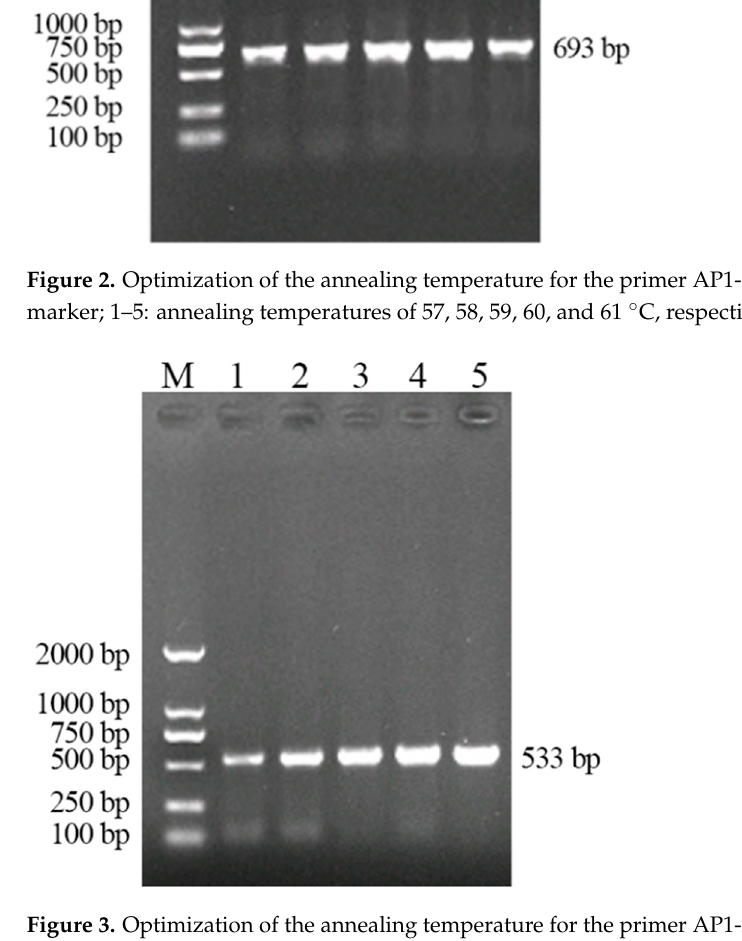
Figure 3. Optimization of the annealing temperature for the primer AP1-2/AP3-1. M: DL 2000 DNA marker; 1–6: annealing temperatures of 58, 59, 60, 61 and 62 °C, respectively.